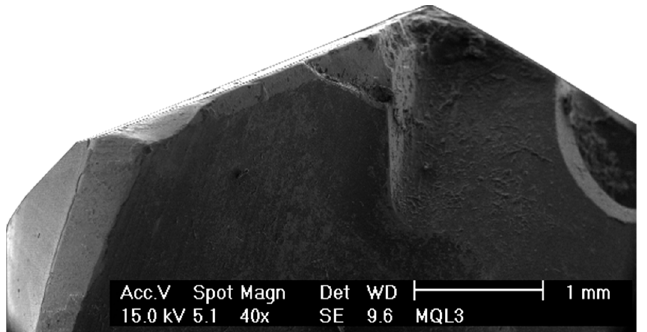
Figure 3. Wear of the tool tested on a Ti/CFRP/Ti stack with the lower lubrication level (3 mL/h), after 40 holes.